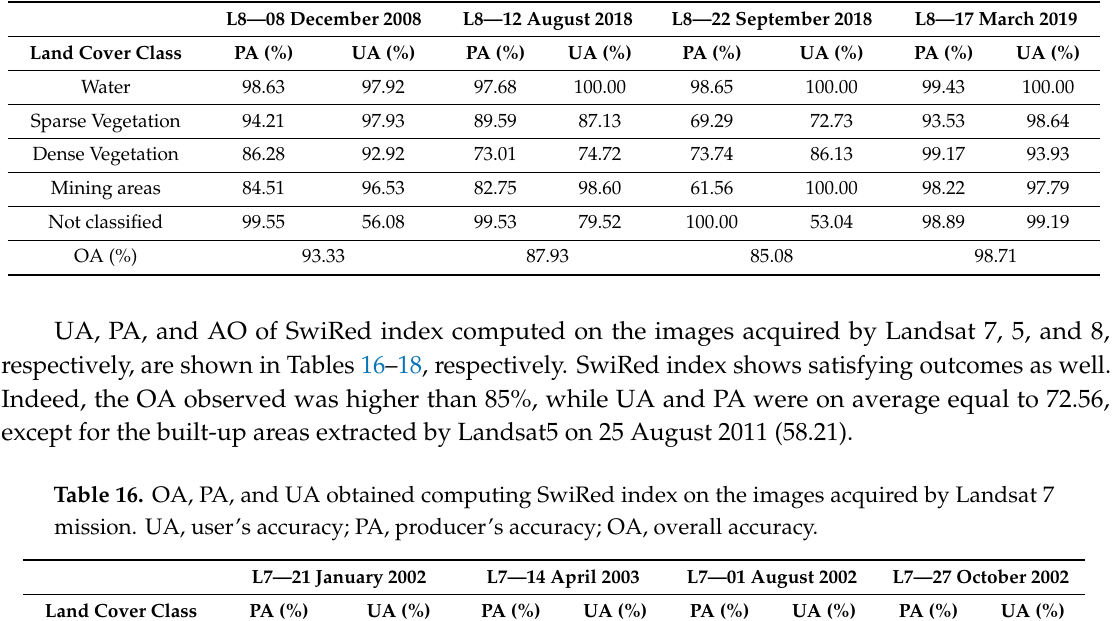
Table 15. OA, PA, and UA obtained accuracy computing STRed on the images acquired by Landsat 8 mission. UA, user’s accuracy; PA, producer’s accuracy; OA, overall accuracy.